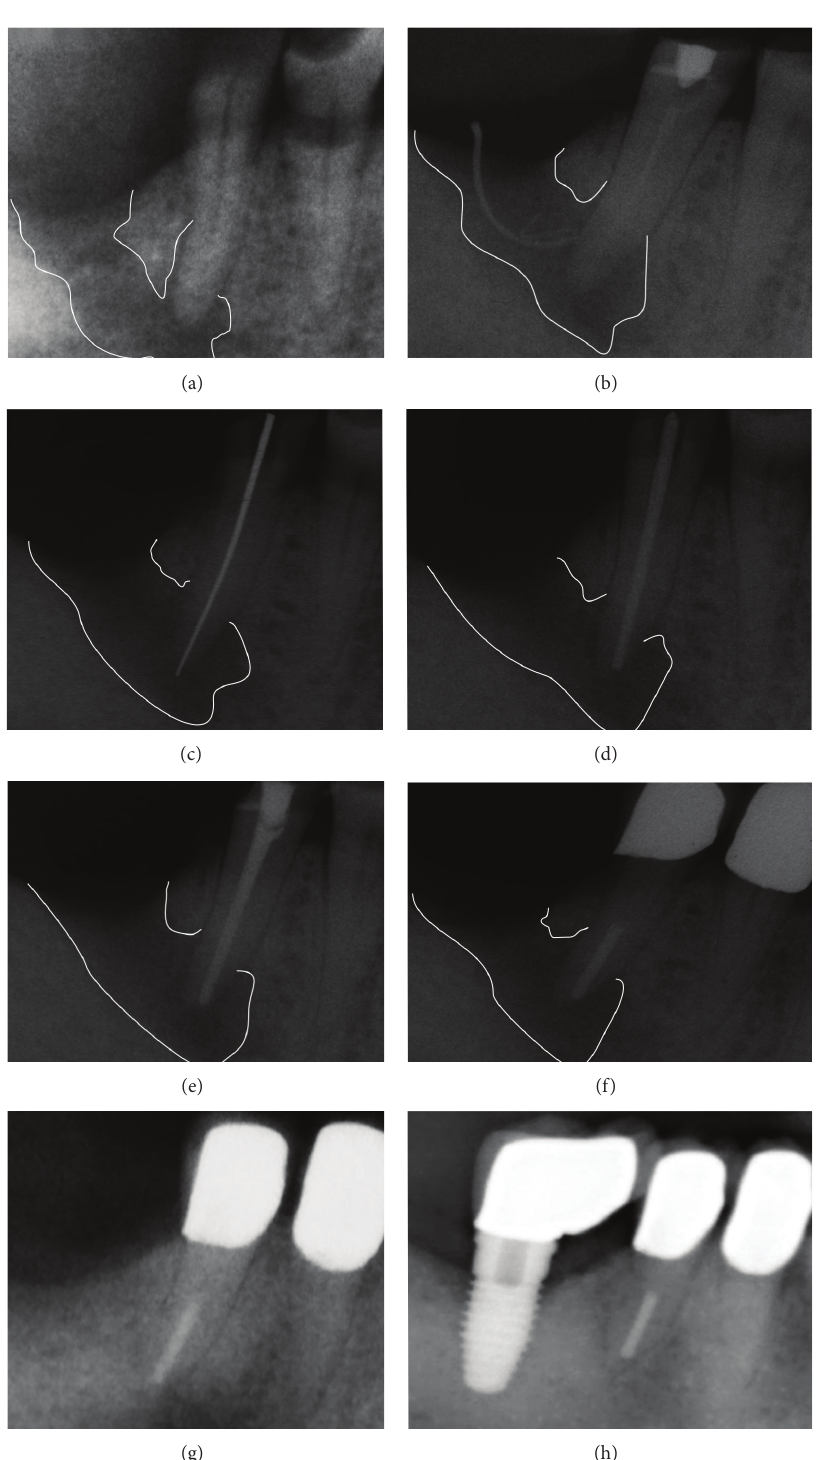
Figure 2: (a) Periapical radiograph prior to root canal treatment. (b) Tracking of the sinus tract with gutta-percha point. (c) Determination of working length. (d) Master point radiograph. (e) Completed root canal treatment. (f) Reconstruction with fibre post and metal-ceramic crown; partial healing of the bone defect. (g) Radiographic situation after complete healing. (h) Radiographic situation of the implant after five years in